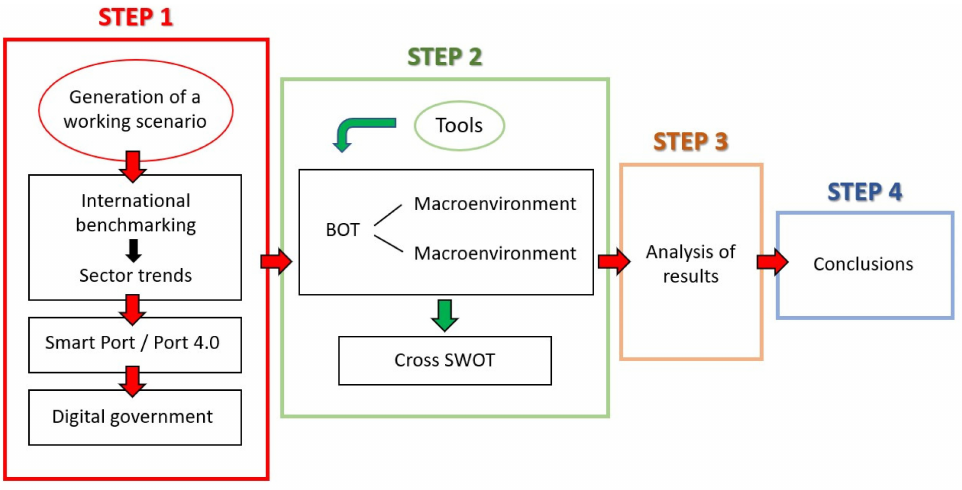
Figure 1. Proposed methodology for the study. Source: own elaboration.